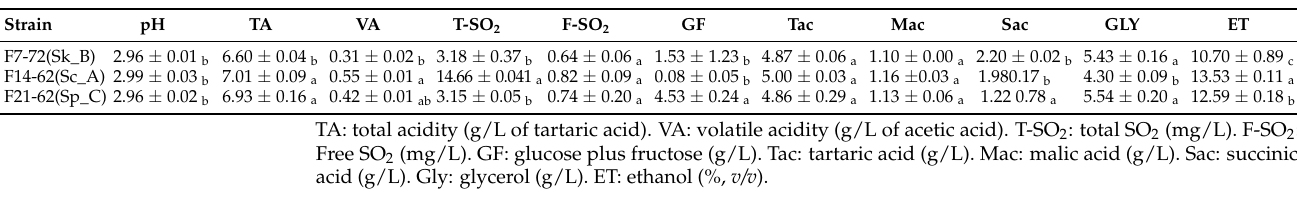
Table 4. Oenochemical parameters of experimental wines produced with S. kudriavzevii (F7 ‐ 72), S. cerevisiae (F14 ‐ 62), and S. paradoxus (F21 ‐ 62). Data are mean (n = 3) ± SD. Different letters for each parameter indicate significant differences (ANOVA: Tukey t ‐ test. p < 0.05—XLStat). TA: total acidity (g/L of tartaric acid). VA: volatile acidity (g/L of acetic acid). T ‐ SO 2 : total SO 2 (mg/L). F ‐ SO 2 : Free SO 2 (mg/L). GF: glucose plus fructose (g/L). Tac: tartaric acid (g/L). Mac: malic acid (g/L).